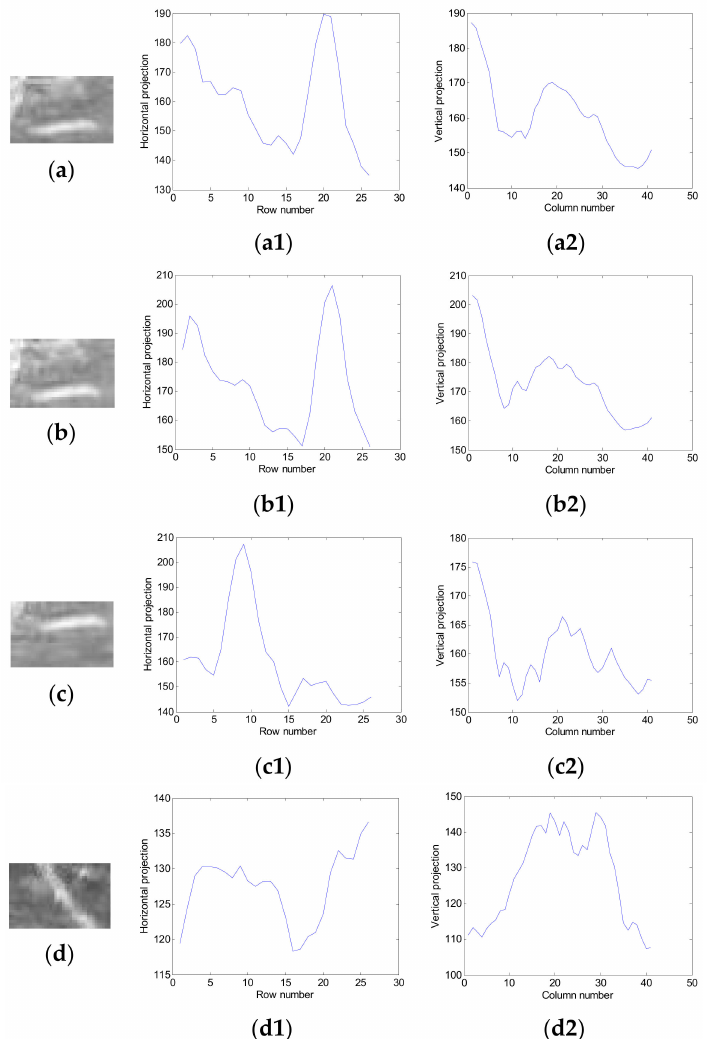
Figure 18. The horizontal and vertical projection curves of the template and candidate images. ( a ) Template; ( a1 ) horizontal projection curve of the template and ( a2 ) vertical projection curve of the template. ( b ) Yellow candidate image; ( b1 ) horizontal projection curve of the yellow candidate image and ( b2 ) vertical projection curve of the yellow candidate image. ( c ) Red candidate image; ( c1 ) horizontal projection curve of the red candidate image and ( c2 ) vertical projection curve of the red candidate image. ( d ) Blue candidate image; ( d1 ) horizontal projection curve of the blue candidate image and ( d2 ) vertical projection curve of the blue candidate